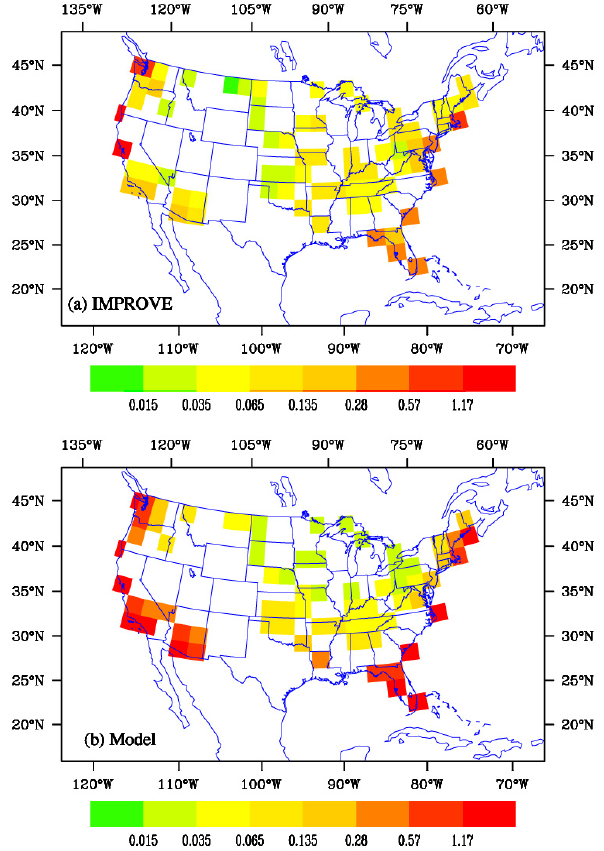
Fig. 7. Inland transport of submicron sea-salt mass comparing between (a) the IMPROVE dataset and (b) the model using the CMS source function with solubility factor of 0.5, unit: µgm − 3 . IMPROVE data are the year average of 2006, PM 2 . 5 (diameter < 2.5µm) chloride multiplied by 1.8. Model values are the aver- ages of March, June, September 2006, with upper limit of 0.95µm in dry radius.